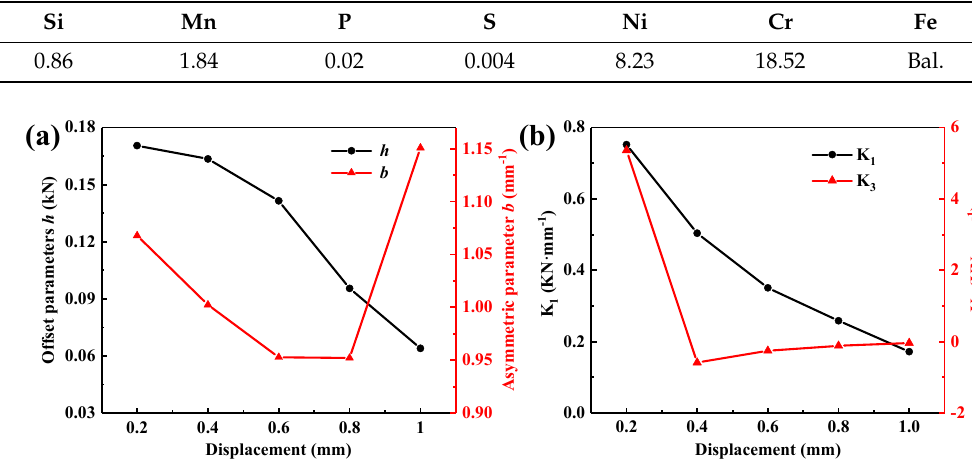
Table 1. Main characteristics of pot-shaped metal rubber.